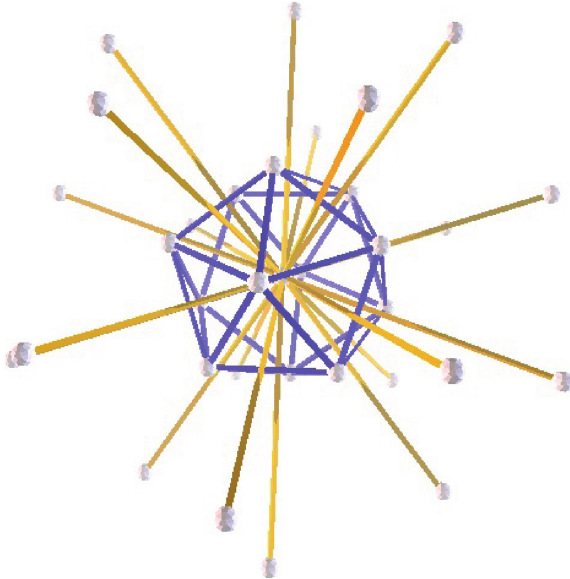
Figure 8: The normal vectors 𝑋 1 ,...,𝑋 20 .